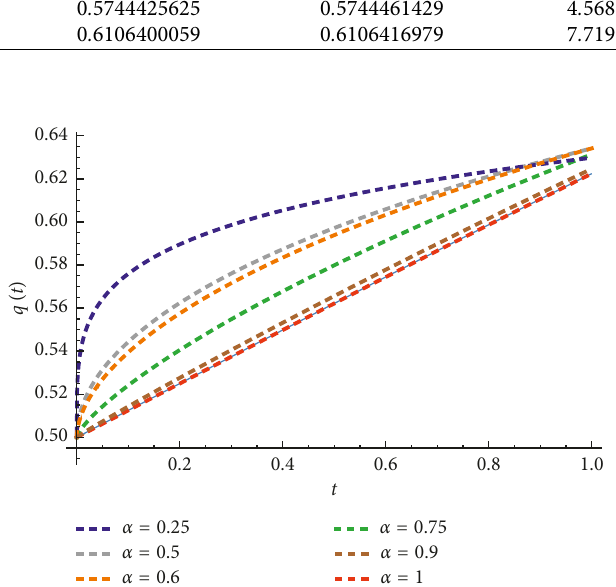
Figure 2: FRPS solution plots of Example 1 for different values of α .